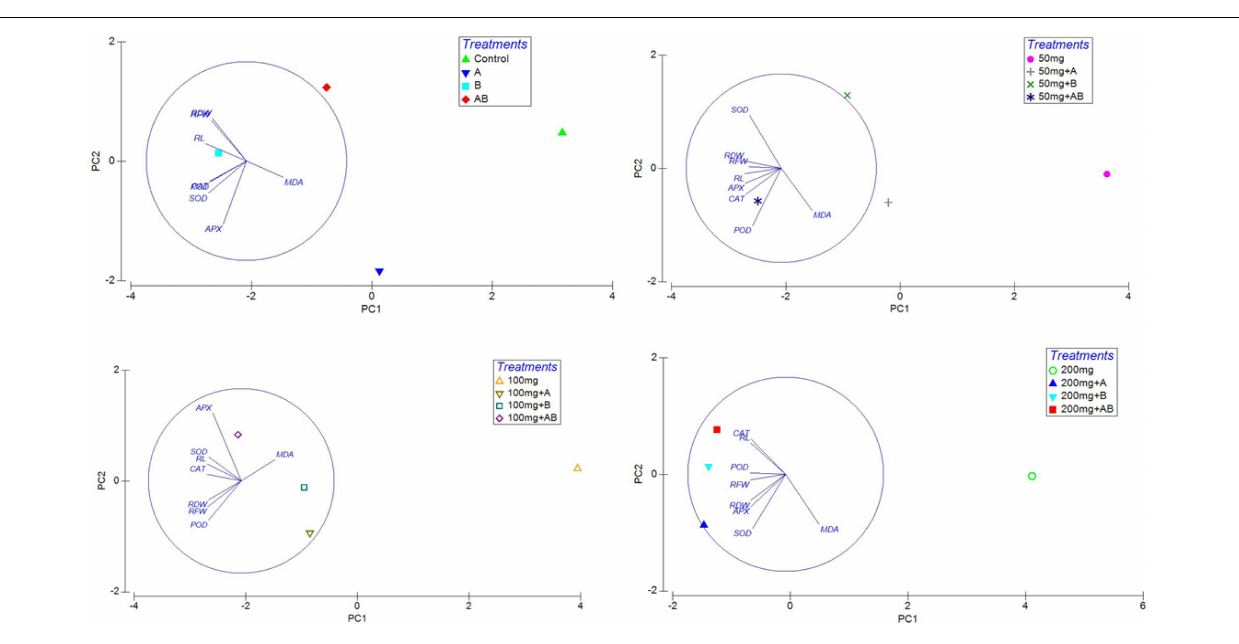
consortium showed the highest increase of 170% (34.8 EU mg − 1 protein) in root SOD when compared with non-treated plants. Under 200 ppm of HMs, root SOD ranged from 9.2 to 16.2 EU mg − 1 protein. Plants applied with Citrobacter werkmanii strain WWN1 showed an increase of 75% (16.2 EU mg − 1 protein), while Enterobacter cloacae strain JWM6 raised